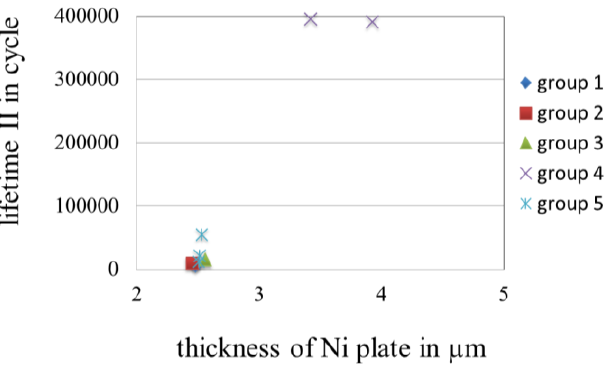
Figure 26. Effect of thickness of nickel